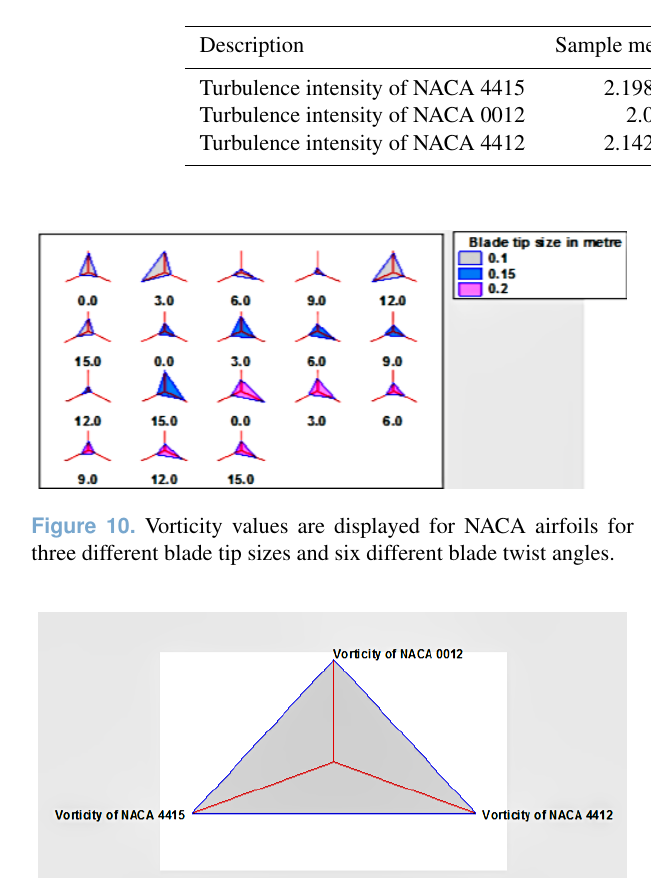
Table 2. Data variables for turbulence intensity.